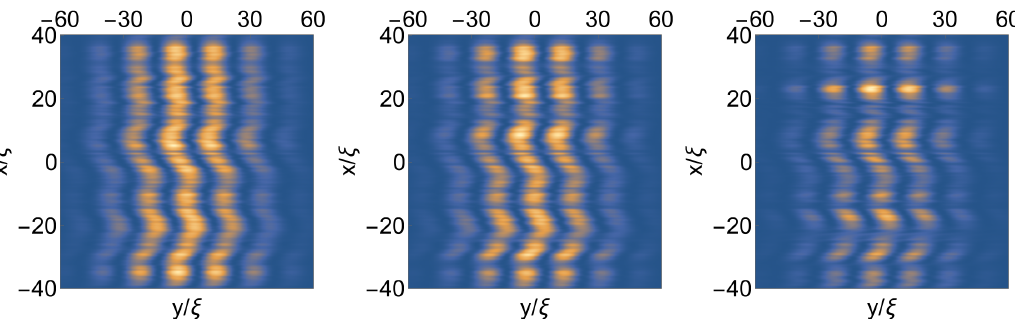
( x , (cid:126) r , t + t ) , with t = 16ms Figure 6: Outcomes for projective measurements of ˆ ρ tof 1 0 1 = 14 ξ/ v , created using (29). From left to right, the temperatures are and t 0 k T = 0.1 ħ h ω ⊥ , k T = 0.3 ħ h ω ⊥ and k T = 0.7 ħ h ω ⊥ . To allow for an easy compari- B B B ( x ) has been used throughout, whereas the eigenvalues son, the same eigenvalue ϕ a ϕ ( x ) are drawn from shot to shot, using the temperature-dependent distribution s functions for the symmetric sector computed in Section 5.1. The other parameters used here are as presented in Section 5.3.